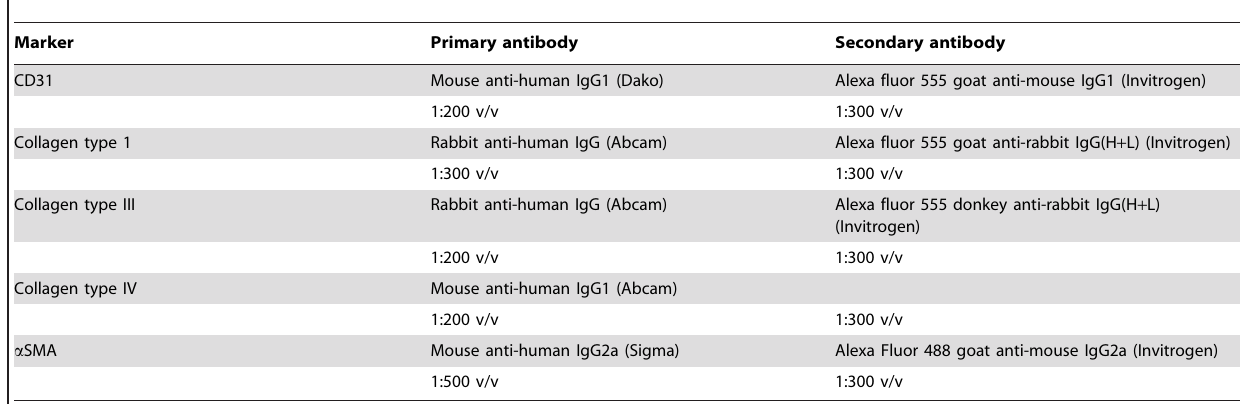
Table 2. Antibodies and corresponding secondary antibodies used for immunofluorescence.